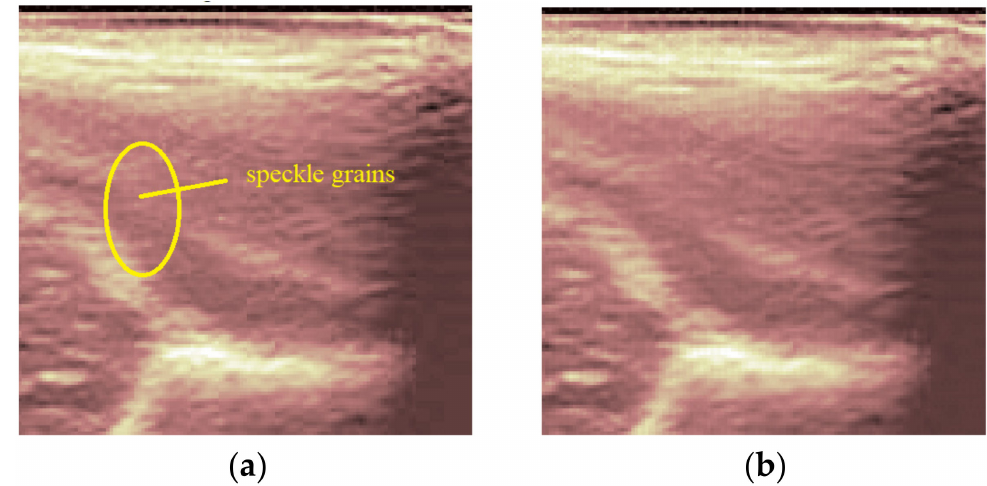
Figure 6. Comparison between the same zoomed region of interest in the original image ( a ) and the denoising result ( b